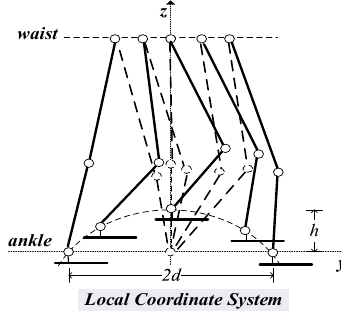
Fig. 2. Diagram of key frames of straight